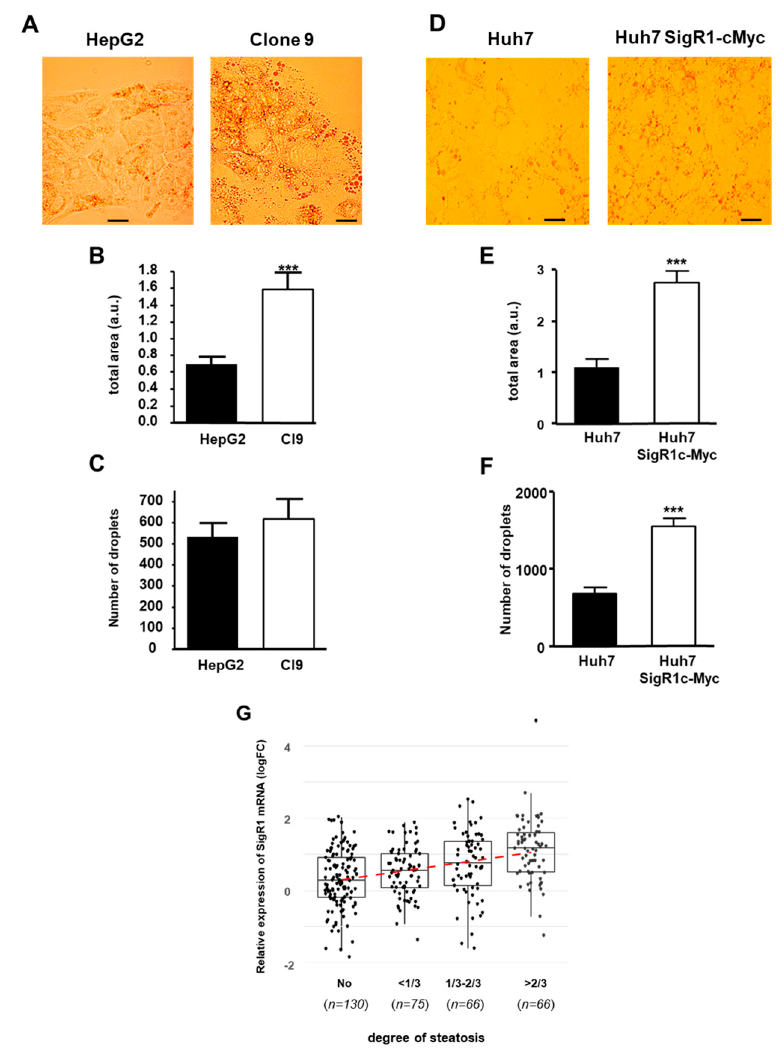
Figure 7. Overexpression of SigR1 increases lipid storage by HepG2 and Huh7 cells. ( A ) Oil Red O staining, ( B ) quantification of staining, *** p = 0.0008, and ( C ) count of droplets, p > 0.05 of HepG2, and HepG2 overexpressing SigR1 cells (C9). Oil Red O staining ( D ), quantification of staining p < 0.0001 ( E ), and count of droplets *** p < 0.0001 ( F ) of Huh7 and Huh7 overexpressing SigR1 (Huh7 SigR1c-myc) cells. Data are shown as mean SEM, ( n = 4, > 20 cells for each determination), t-Test. ( G ) The positive ± correlation between the level of SigR1 mRNA expression and the level of steatosis observed in HCA. HCAs were sorted into four groups according to their level of steatosis (see Table S1). Linear regression: p -value <